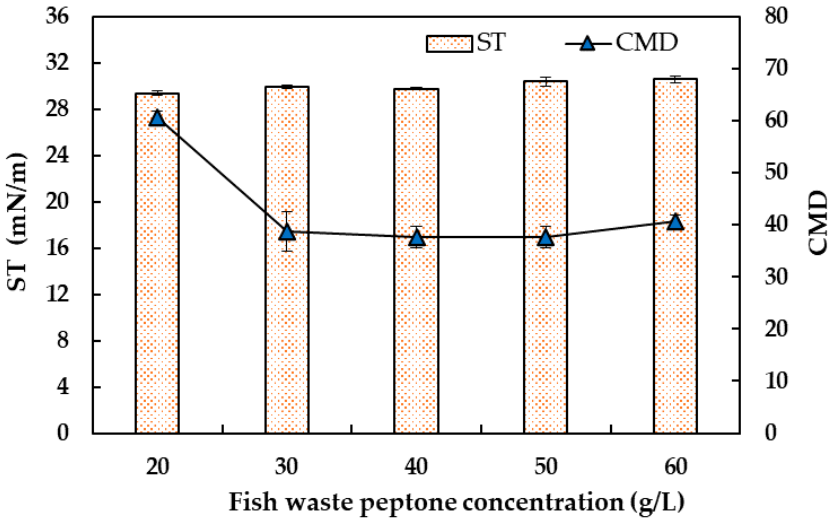
Figure 2. Bench-scale experiments exploring different fish waste peptone concentrations.